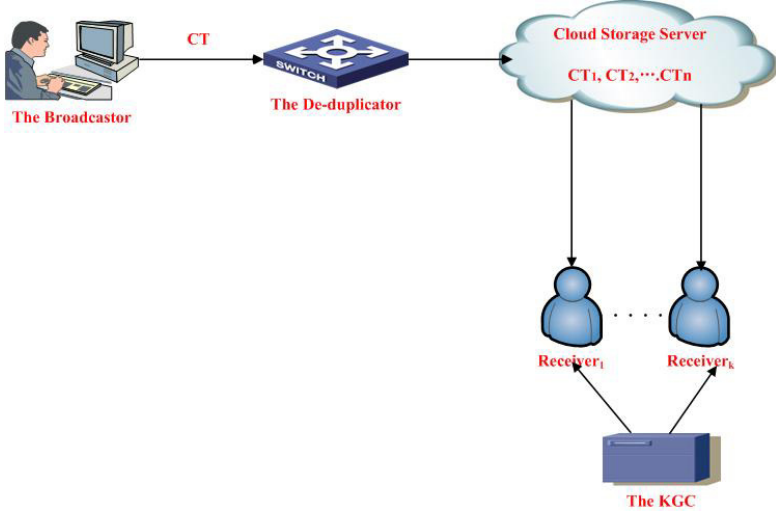
Figure 1. The system model of the PMCBED